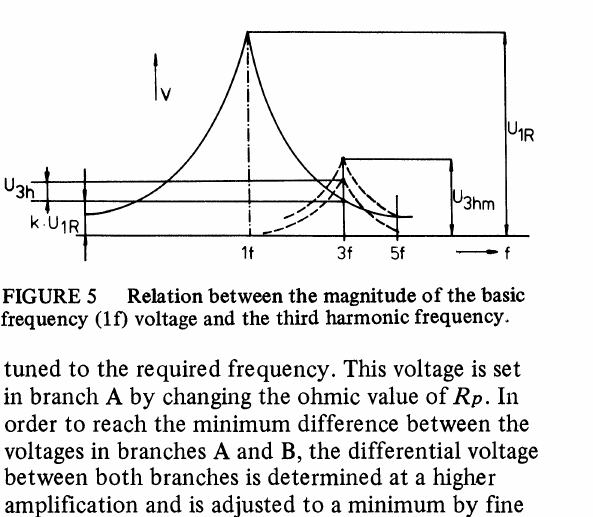
Relation between the magnitude of the basic frequency (lf) voltage and the third harmonic frequency.